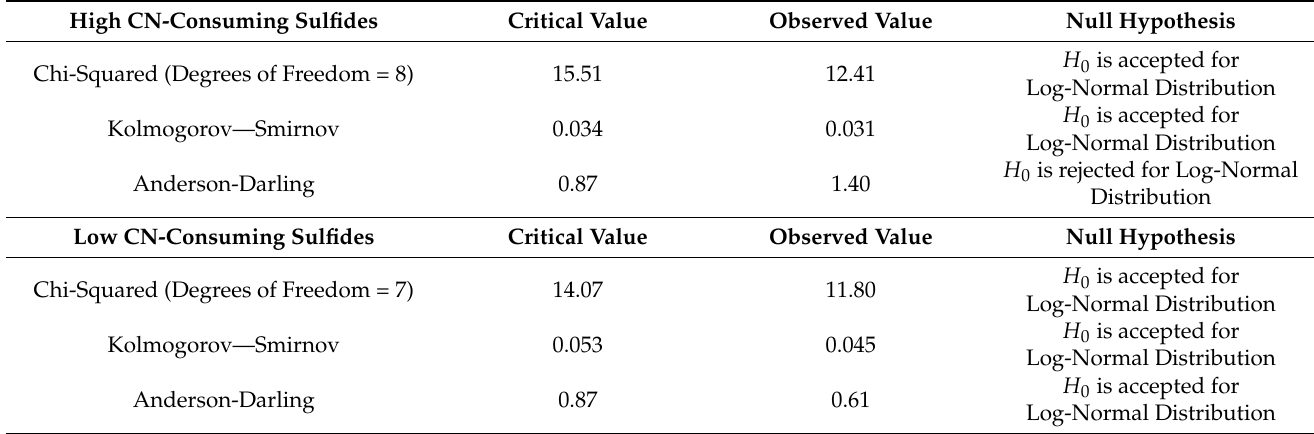
Table 5. Summary of goodness of fit tests for the log-normal, α = 0.05.